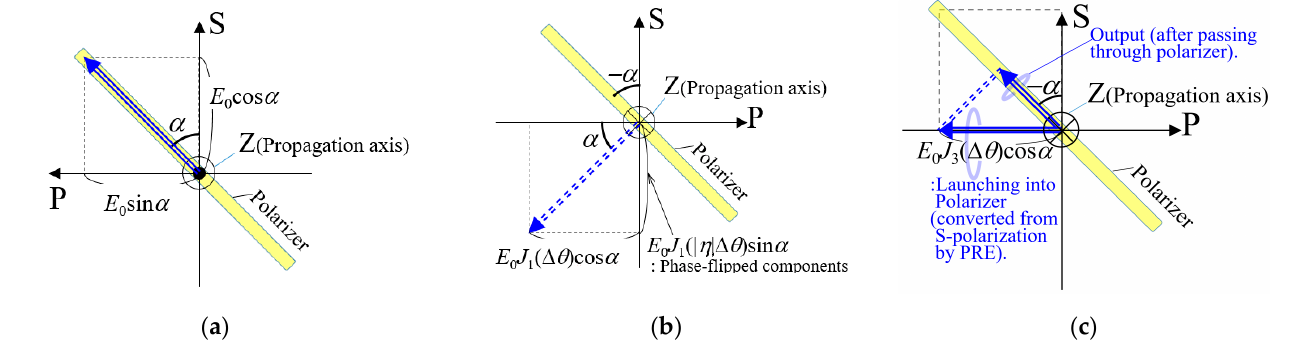
6 of 13 From Equations (10) and (11), the optimum value of α is expected to be 45°. Figure 4a shows the dependence of P 1 / P 3 on Δ θ for several | η | , assuming that ξ = 10 4 (40 dB). The Δ θ , giving the bottom of each dip, corresponds to the solution of Equation (9). With a decreas- ing | η | (i.e., an increase in attenuation), the dip of each plot gradually shifts to the higher Δ θ . Additionally, the dip becomes narrower with a decrease in | η |, originating from the fact that the slope of J 1 ( x ) increases when the argument x is far from x 0 = 1.841, which gives a local maximum of J 1 ( x 0 ). This fact is also summarized in Figure 4b, which show depend- ence of the maximum suppression ratio of the 1st-order optical sidebands and 3 dB width